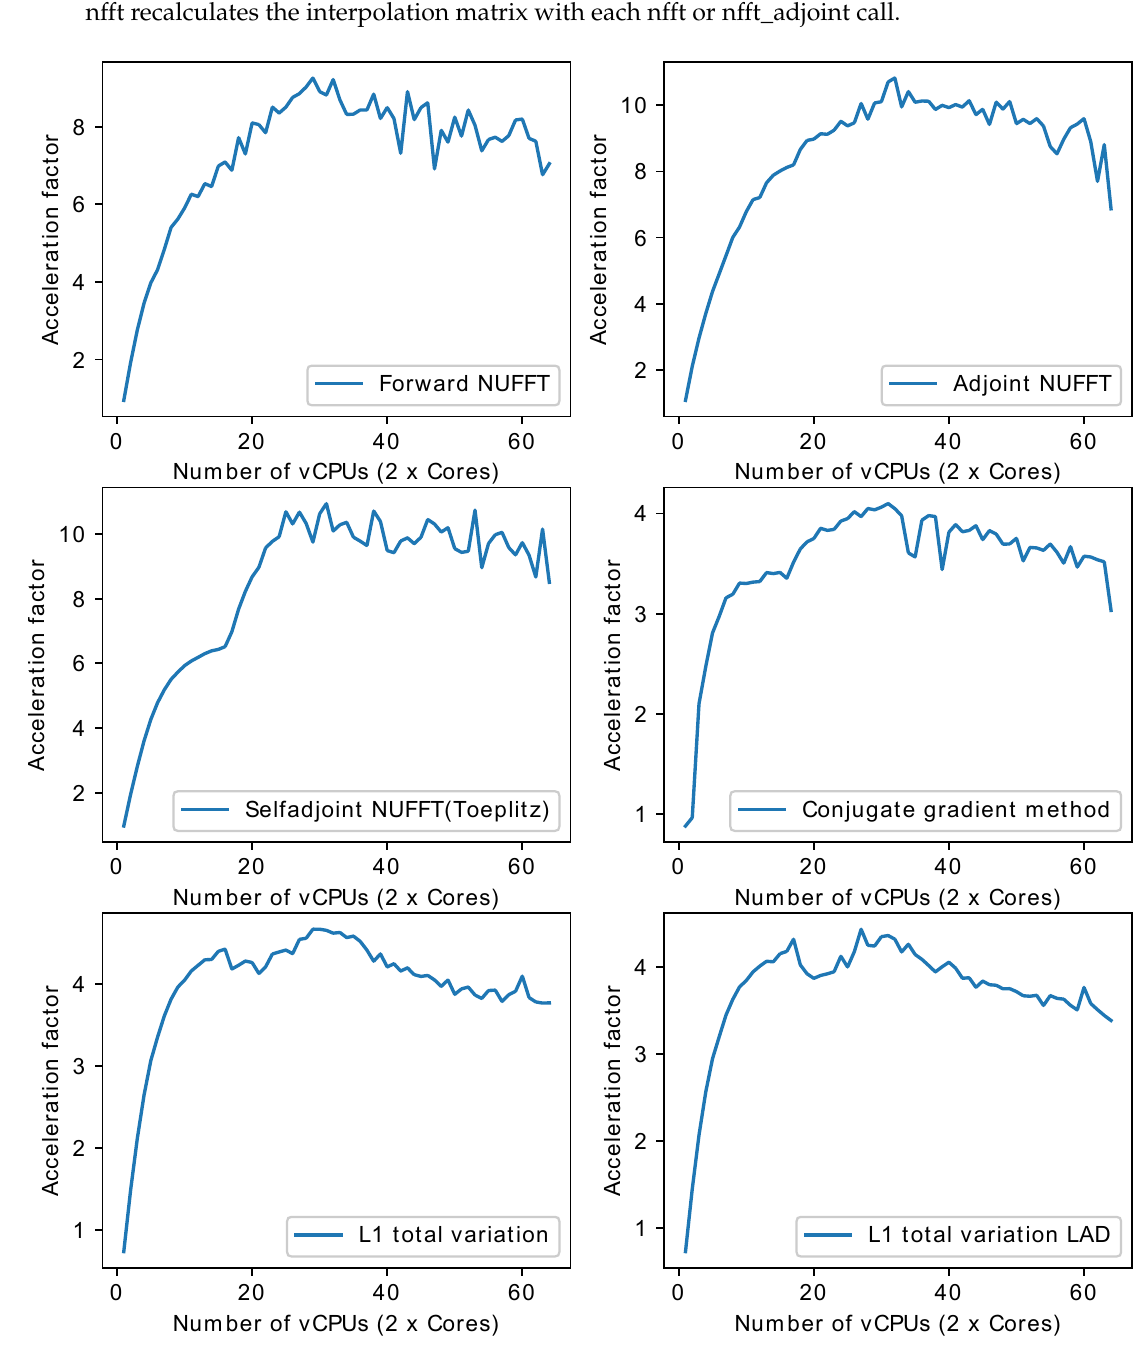
Figure 10. Acceleration factors against the number of virtual CPUs (vCPUs). Optimal performance occurs around 30–32 threads. There is no substantial benefit from more than 32